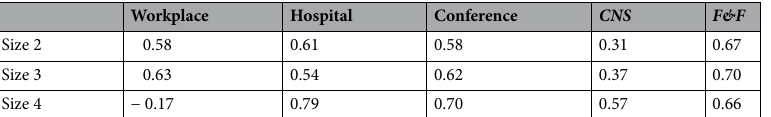
Table 1. Burstiness measure for distributions P s ( E ) reported in Fig. 3. The burstiness has been computed according to the formula firstly proposed by Goh and Barabási 43 and successively normalised 44 in order to allow a comparison between samples with different number of